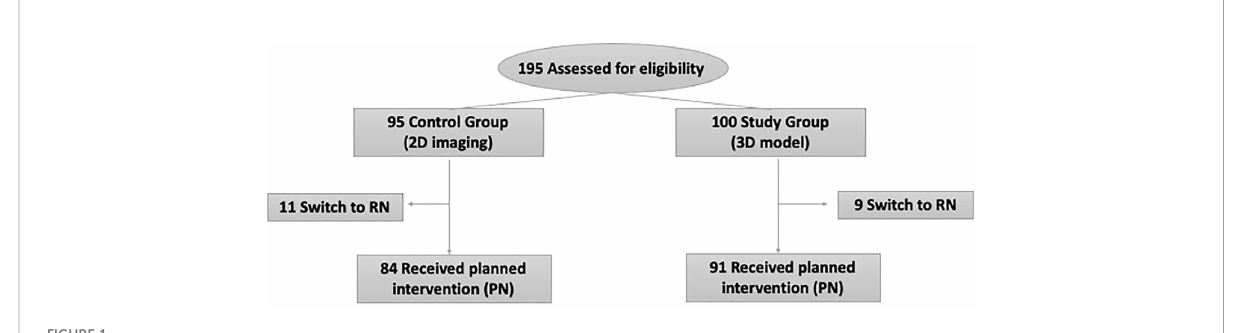
FIGURE 1 Flow chart of participants in the